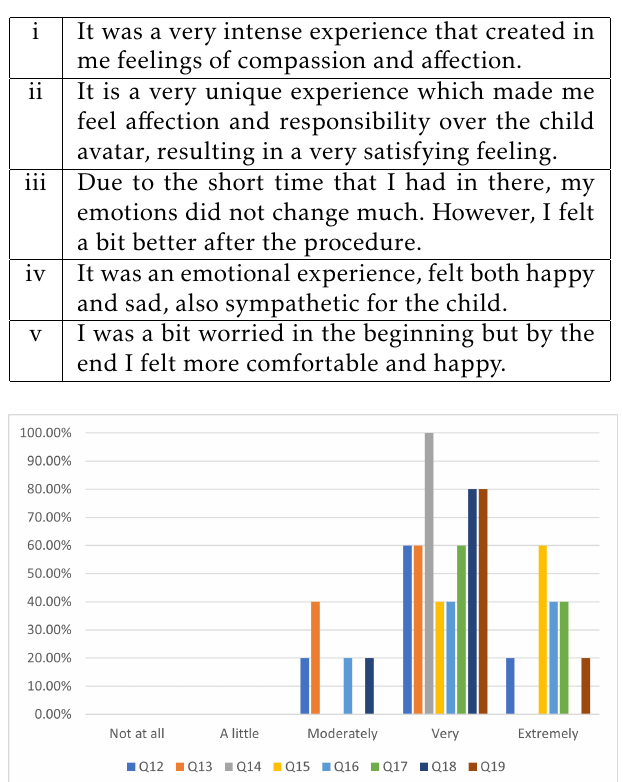
Figure 6. Overall percentage selection for questions Q6 to Q10 in Table 1. Table 3. Answers to Q11 in Table 1.